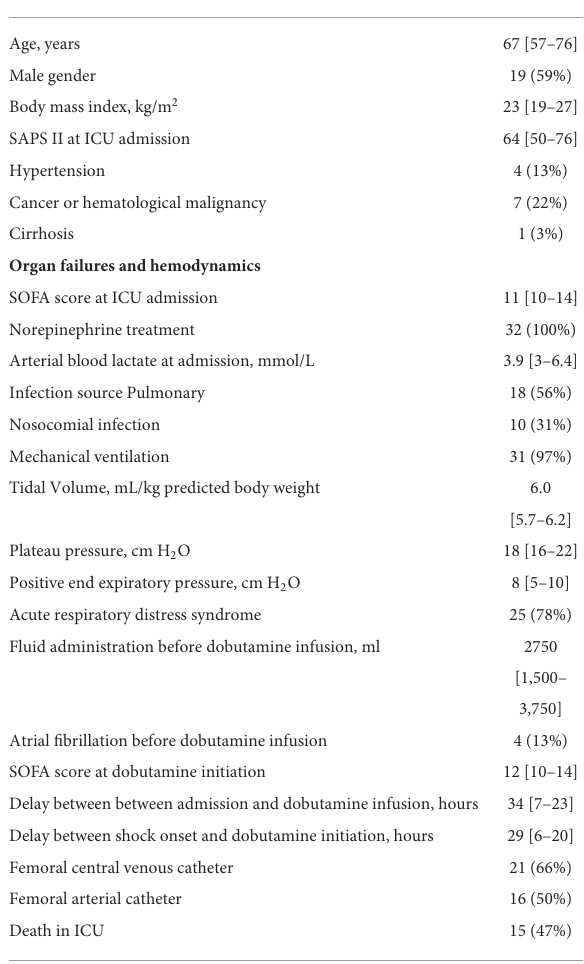
TABLE 1 Characteristics of patients with septic shock and myocardial dysfunction. Clinical characteristics and